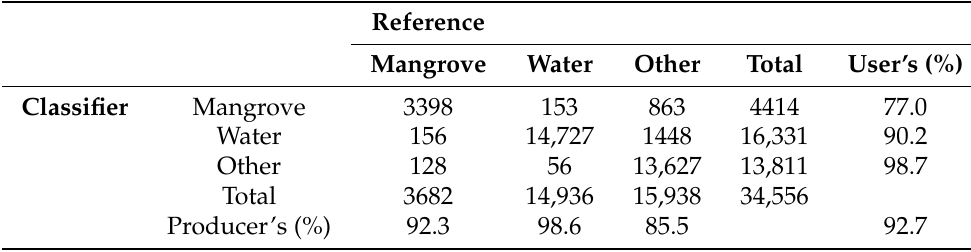
Table 3. Results of the spatiotemporal accuracy assessment for COLD over the five study sites, for the overall